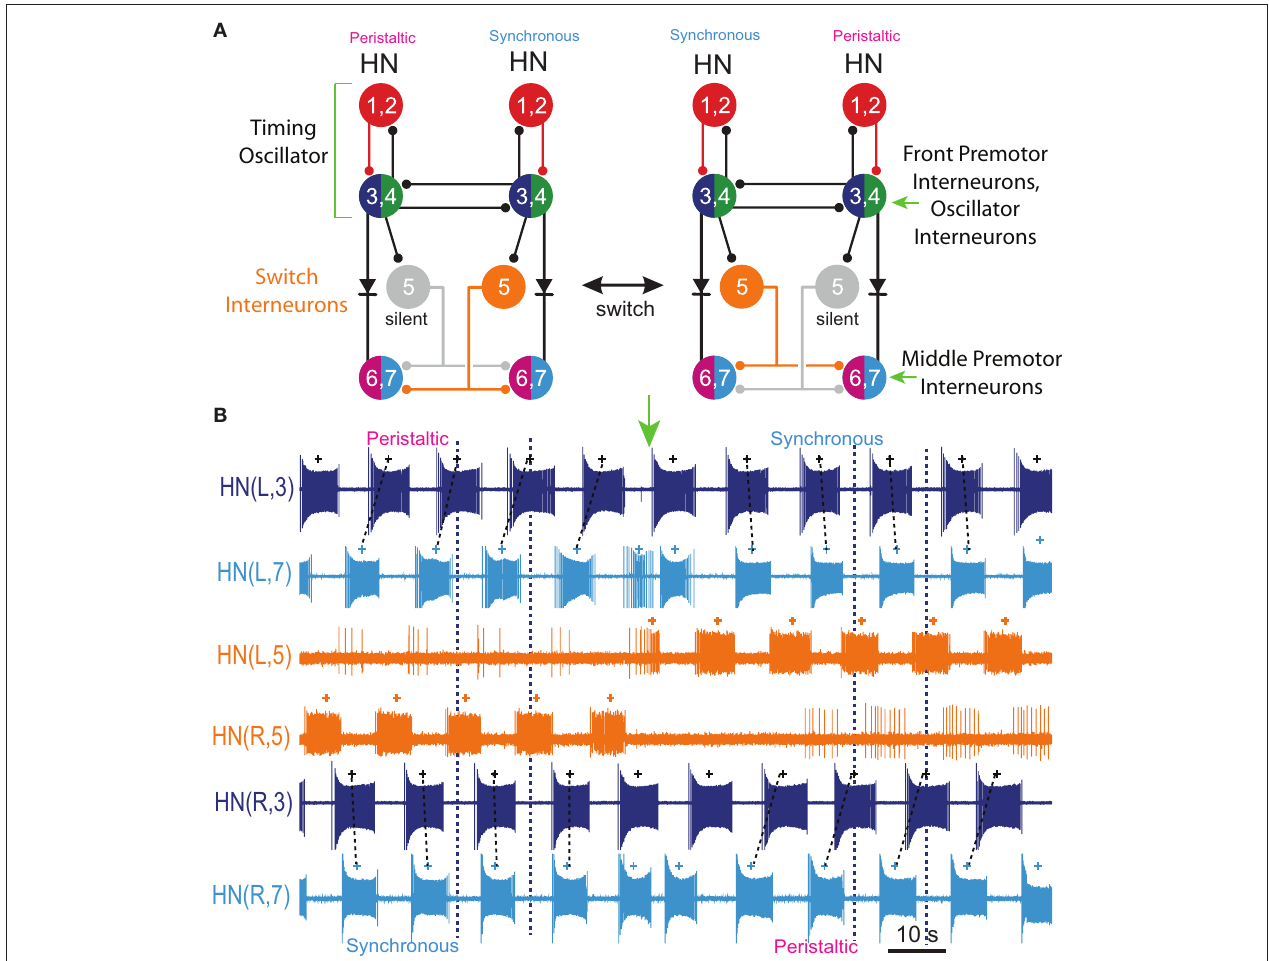
switches the phase of the premotor interneurons on the two sides from peristaltic to synchronous and vise versa. In this and all subsequent figures, marker symbols indicate the time of the middle spike for each burst. Normally the middle spike of an HN(4) interneuron is used as a phase reference to compute phase (see Materials and Methods), but in this experiment the HN(4) interneurons were not recorded. The dark blue vertical dashed lines indicate the firing phase of the peristaltic HN(3) interneuron to ease comparison of relative (unilateral) phase during the two coordination modes, and slanted dashed lines indicate phase differences between ipsilateral front [HN(3)] and middle [HN(7)] premotor interneurons corresponding to peristaltic (large HN(7) lead) and synchronous (small HN(7) lag) coordination modes. The switch is indicated with a vertical arrow. In such switches, the front premotor interneurons remain fixed in phase and the middle premotor interneurons shift their phase with respect to them (Calabrese, 1977; Norris et al., 2006). In this and all subsequent figures, the heart interneuron (HN) is indicated by midbody ganglion number (1–7), and, if necessary, body side (L or R). Standard color and marker codes are also applied in this and in all subsequent figures: red/diamond, HN(1,2) interneurons; blue/circle, HN(3) interneurons; green/asterisk, HN(4) interneurons; orange/open circle, HN(5) interneurons; magenta/triangle, HN(6) interneurons; cyan/square, HN(7) interneurons. Slanted dashed lines indicate the phase